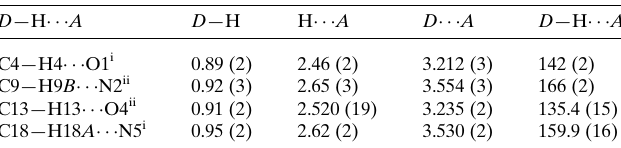
Table 1 Hydrogen-bond geometry (A˚ , (cid:4) ).